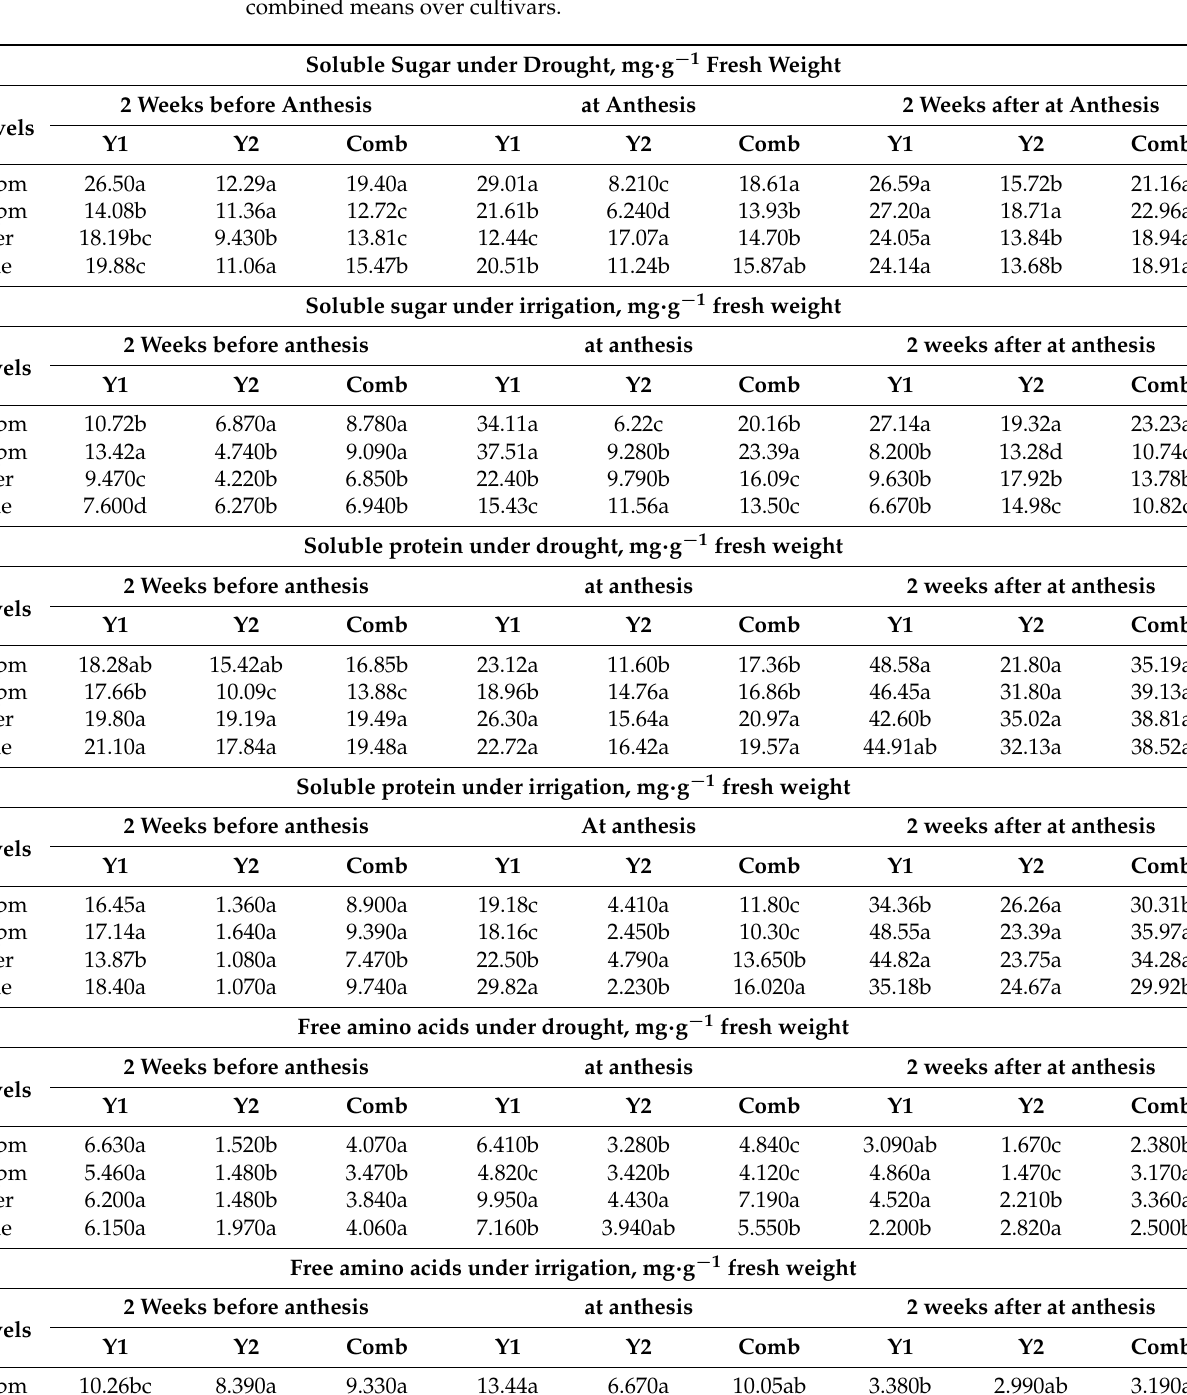
Table 2. Means of the studied traits under drought stress and normal irrigation in the 2 years and combined means over